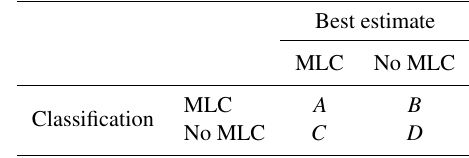
Table 2. Skill score evaluation. Definitions of the evaluation vari- ables A , B , C and D used for the evaluation of the MLC occurrence derived by the classification steps 1 and 2 in comparison to a best estimate of MLC